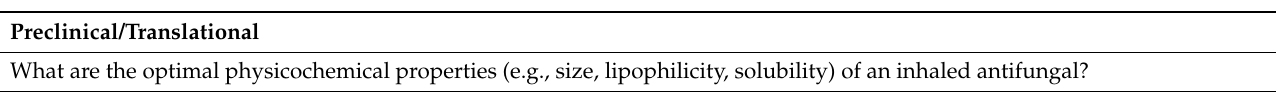
Table 5. Some ongoing and future questions regarding inhaled